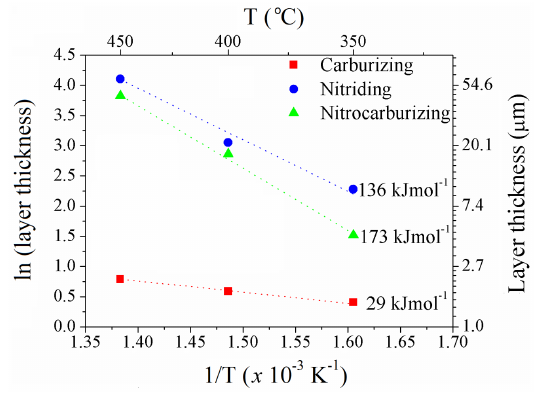
Figure 3. Arrhenius plot of the layer thickness for the low-temperature plasma treated surfaces (for treatments carried out at 8 h).